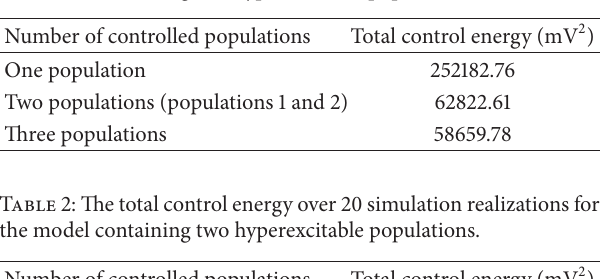
Table 1: The total control energy over 20 simulation realizations for the model containing one hyperexcitable population.